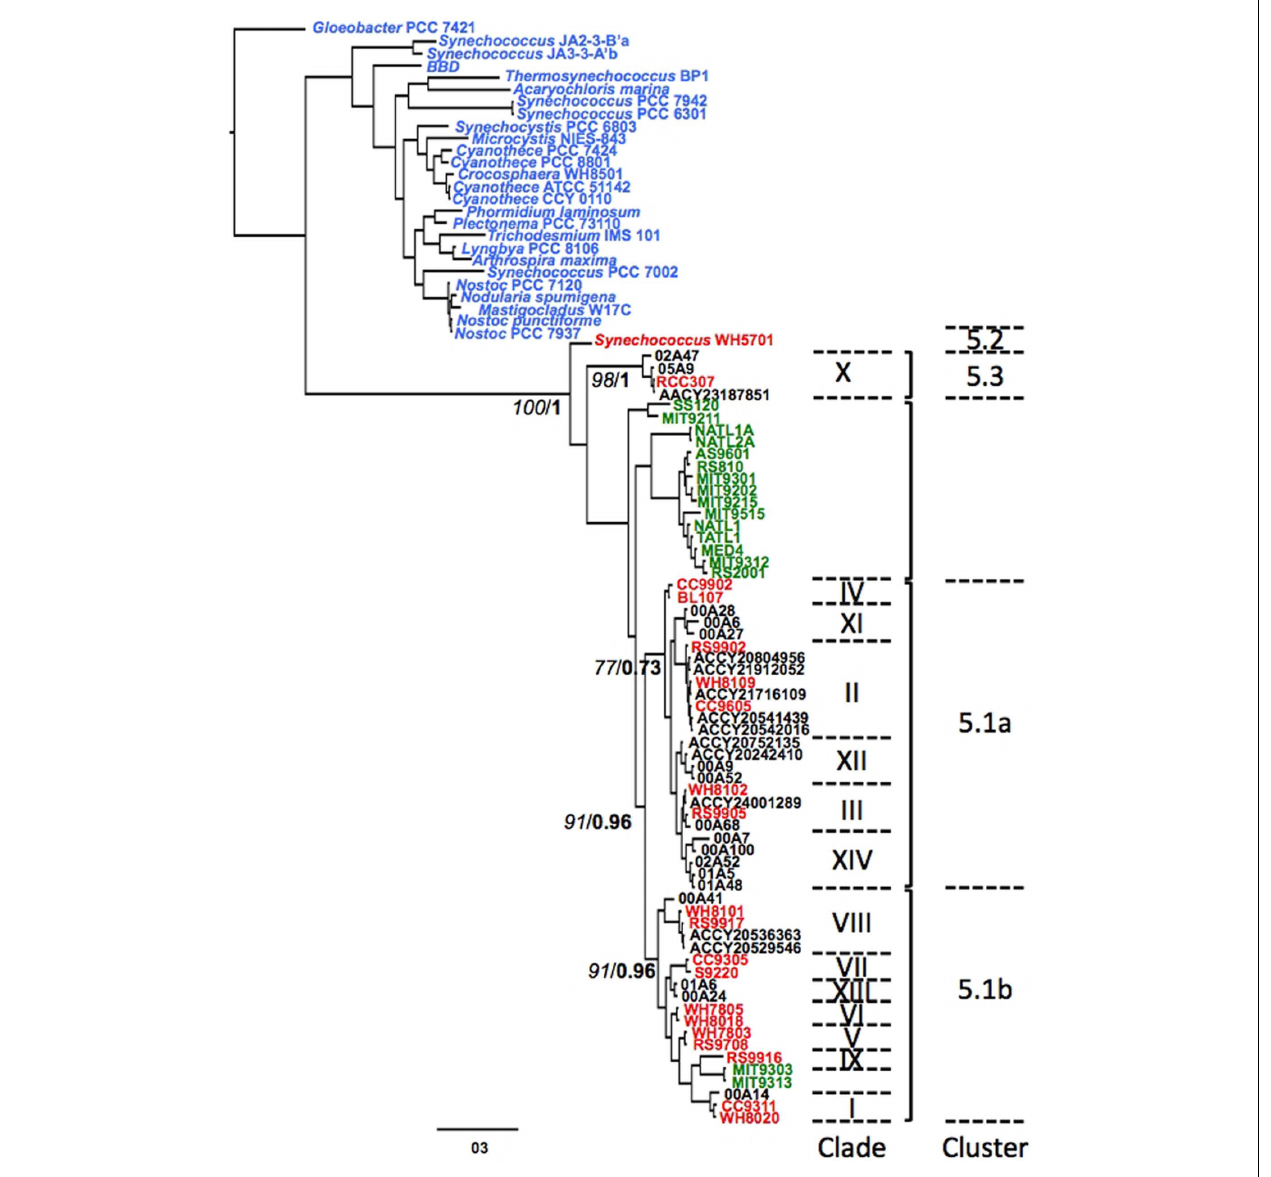
from the Gulf of Aqaba (format xxAyy, in which xx is year, A denotes station A in open waters and yy denotes clone number) were used to represent clusters for which no culture isolates are available. Sequences identified by their ACCY prefix were retrieved from the Global Ocean Survey (GOS) database using Synechococcus NtcA sequences as query in blastn